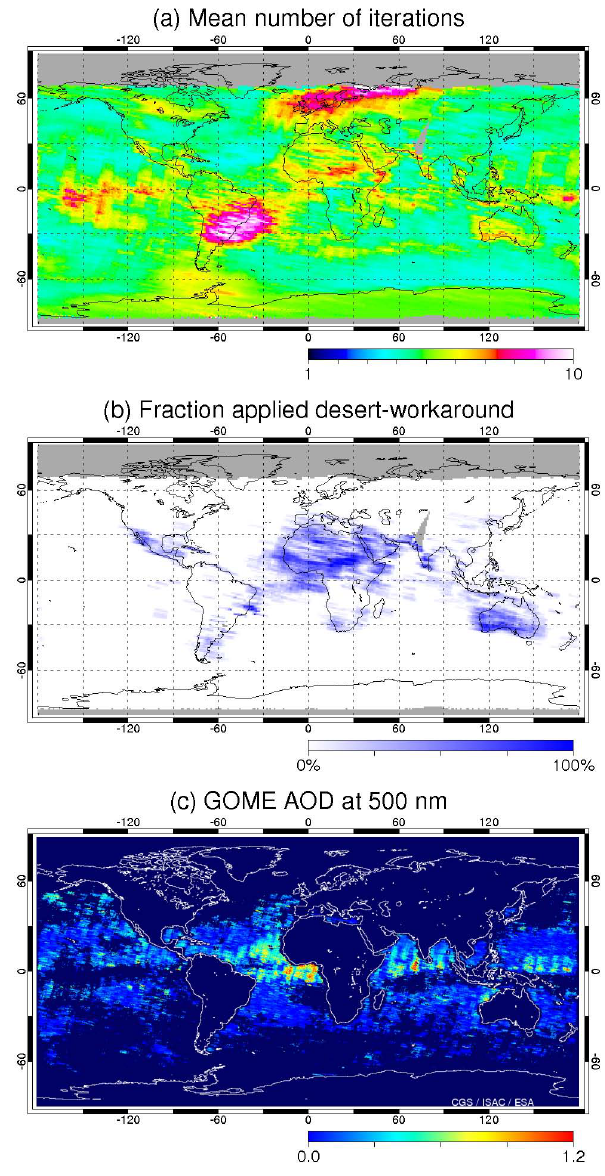
Fig. 5. Retrieval results for February 1998 with the desert workaround. (a) shows the improvement of retrieval results above deserts when compared with Fig. 4a; (b) shows the selectivity of the workaround by mapping for each grid cell the fraction of re- trievals to which it has been applied. The convergence problem due to the dust outbreak flowing out from West Africa towards South America is also solved; as a comparison (c) shows the mean aerosol optical depth (AOD) at 500nm for the same month (taken from